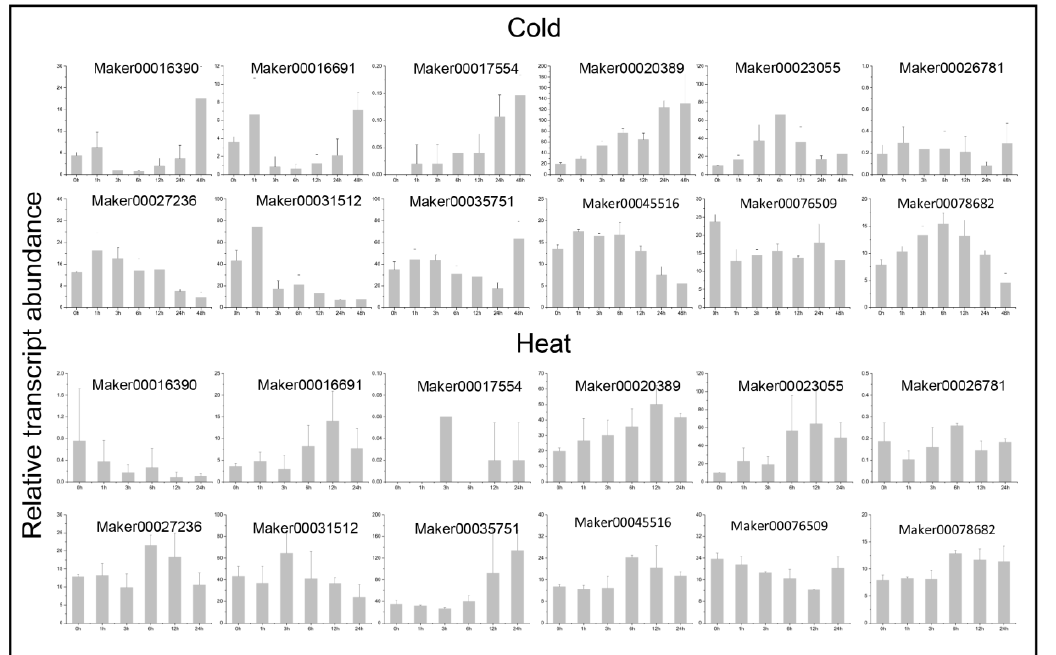
Figure 10. QRT-PCR expression analysis of GRAS genes under abiotic stresses. The data has been normalized, and the bar represents the standard deviation.